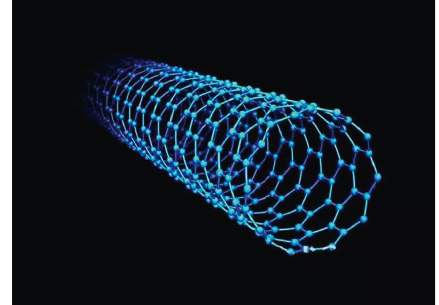
Figure 1: Nanotube molecular